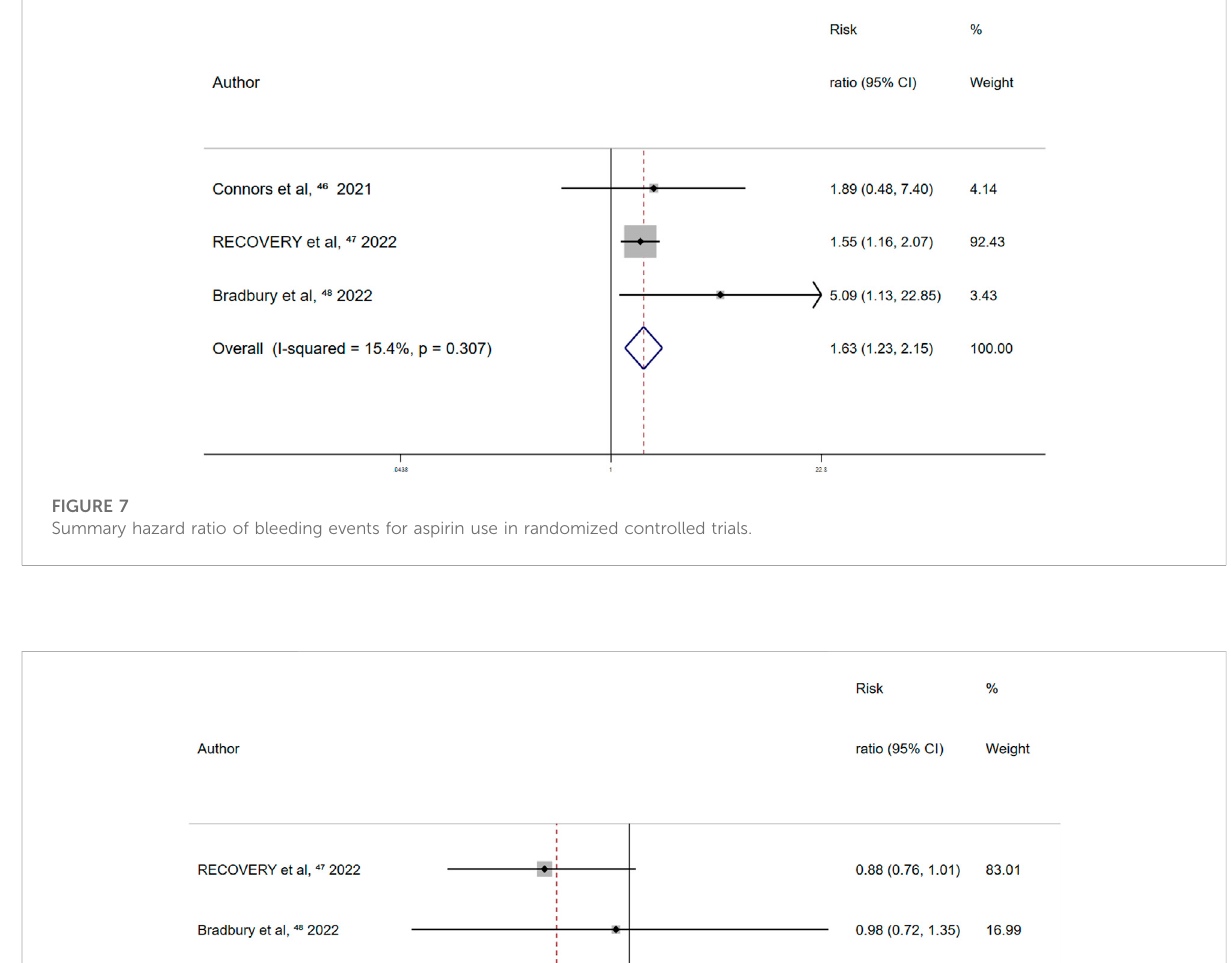
(Figure 10). Aspirin use and overt thrombosis events were not signi fi cantly associated in patients with COVID-19.